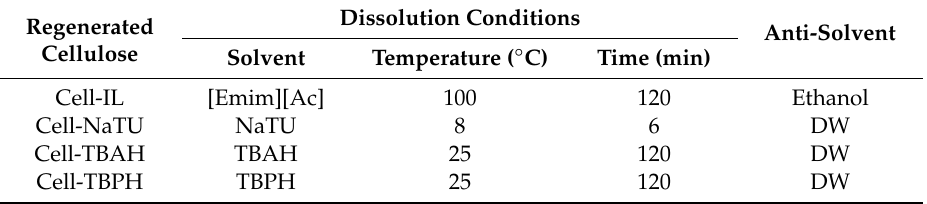
Table 1. Dissolution and regeneration conditions to prepare regenerated cellulose